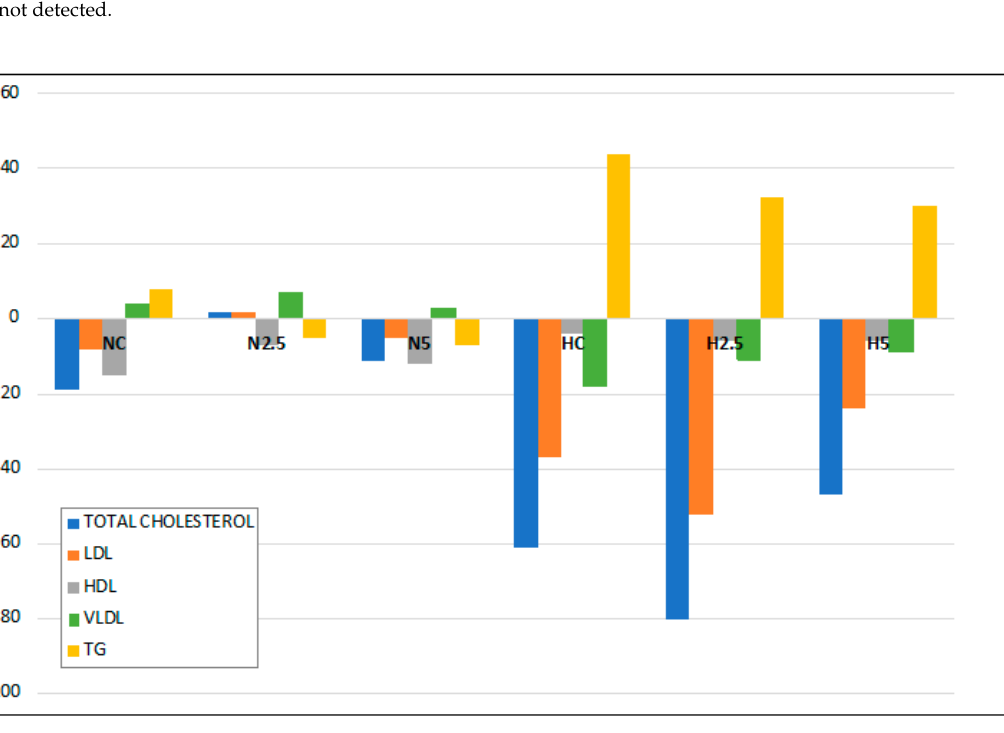
Figure 2. Changes in lipid parameters measured in plasma at the beginning and at the end of the intervention period of 5-weeks for the six experimental groups. LDL: low-density lipoprotein; HDL: high-density lipoprotein; VLDL: very low-density lipoprotein; TG: